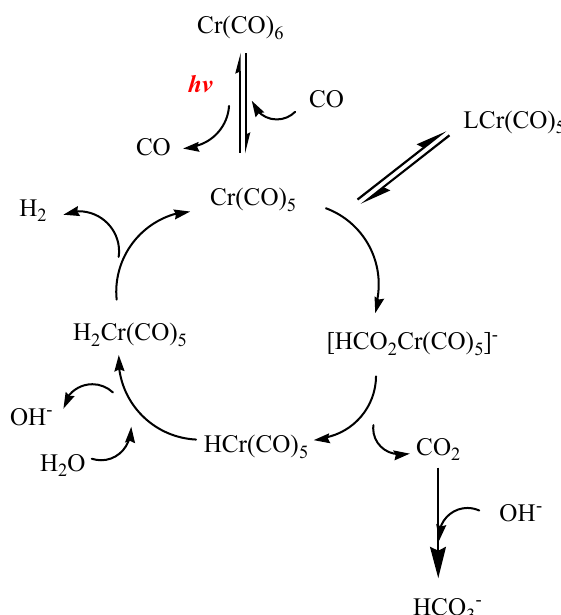
Figure 9. Catalytic cycle for FA dehydrogenation one-photon Light-Assisted Activation (LAA) mechanism. Figure adapted from Reference [58].